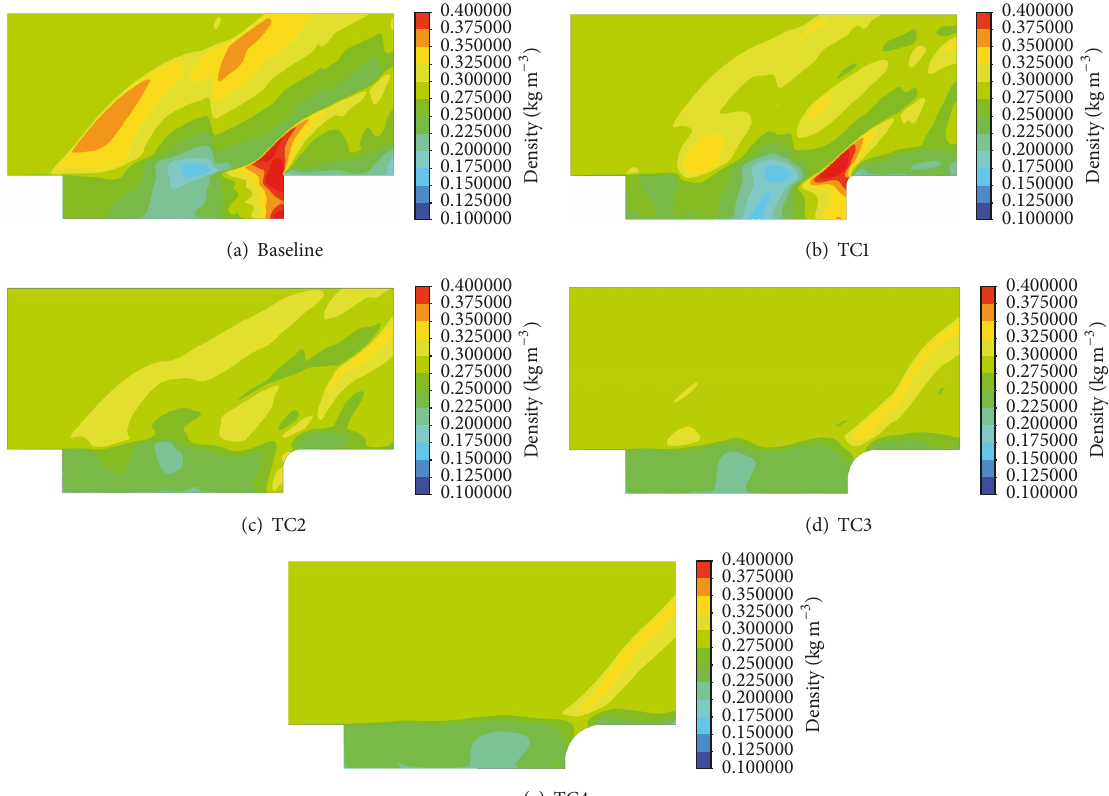
Figure 27: Density contours for baseline and trailing edge curvature cases ( 𝑡/𝑡 𝑅 = 0.55